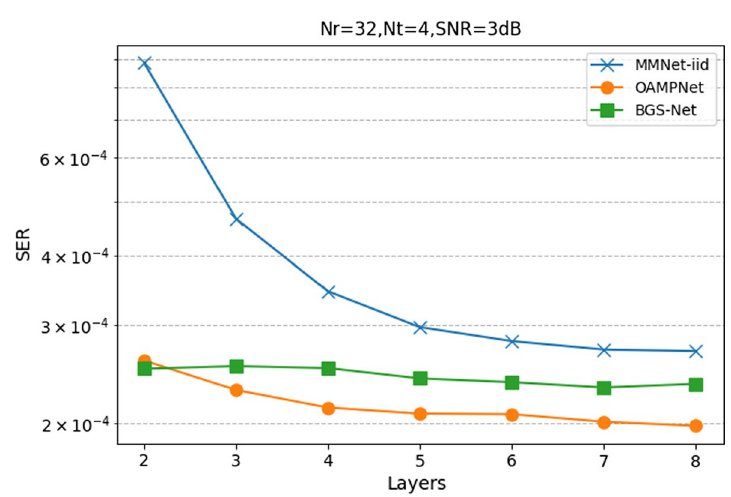
Fig. 10 Effect of the number of network layers on SER under N t = 4 , N r = 32 , QPSK, SAUE